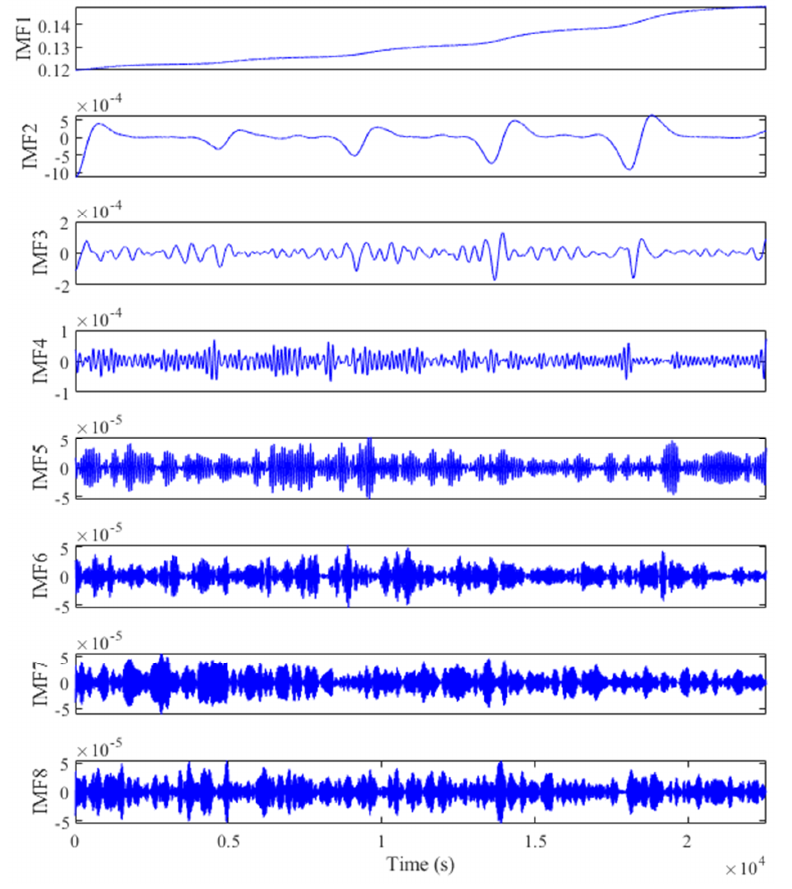
Figure 12. Decomposition results of Improved VMD.